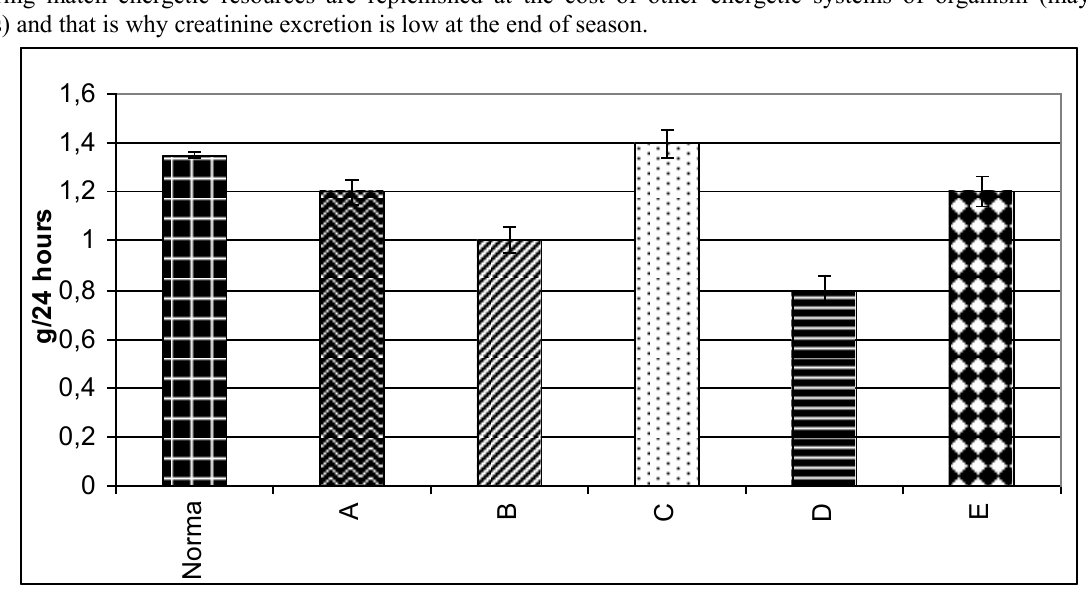
Fig.2. Creatinine excretion of 14-16 years old football players in training and competition